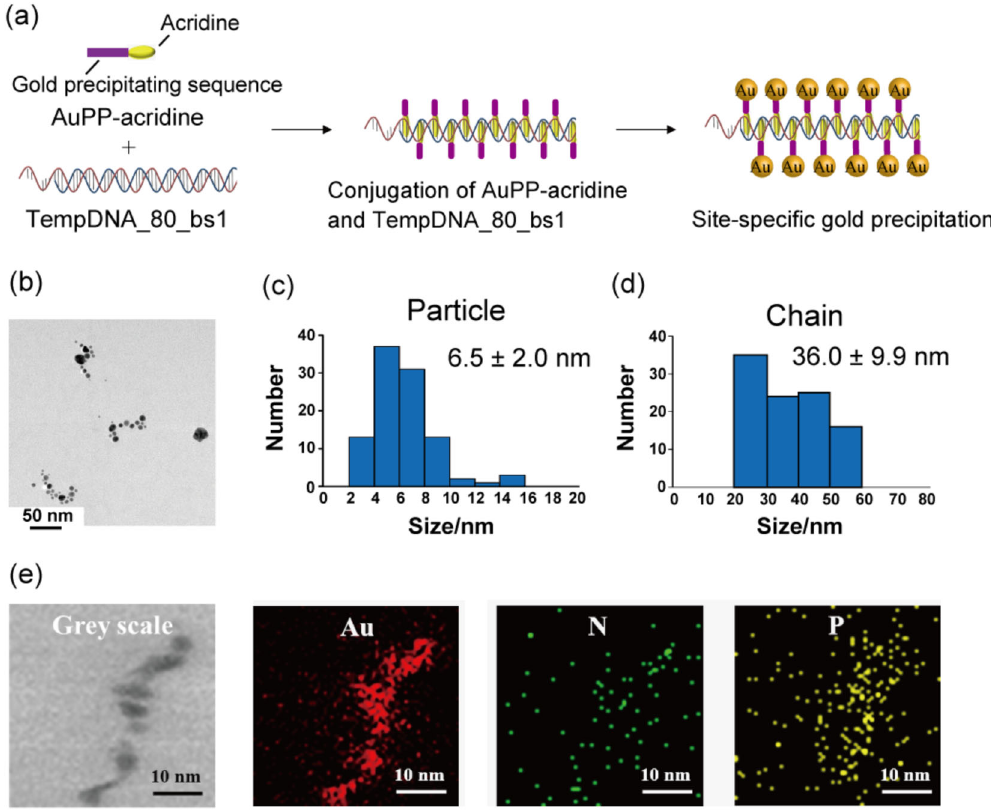
Fig. 3 Site-speci fi c precipitation of gold on double-strand DNA. a Schematic illustration of site-speci fi c gold precipitation using AuPP-acridine and TempDNA_80_bs1. b TEM image of the sample after gold precipitation using AuPP-acridine and TempDNA_80_bs1. c Particle size distribution determined from the TEM data. d Chain size distribution determined from the TEM data. e TEM-EDX mapping images of the sample after gold precipitation using AuPP-acridine and